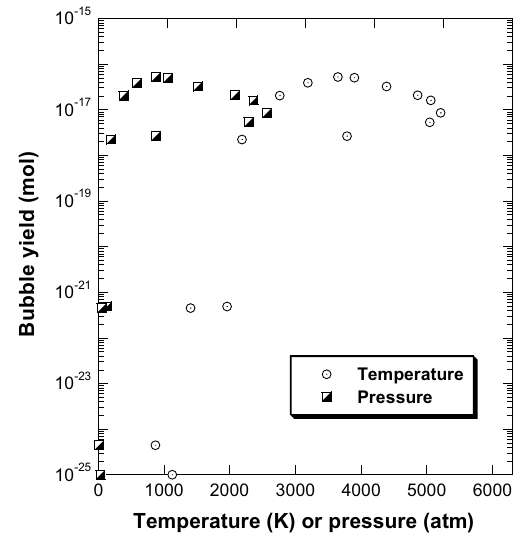
Fig. 2 Amounts of the main oxidants created inside the bubble at the end of the first bubble collapse (conditions—ambient bubble radius: 1.2 µm, liquid temperature: 25 °C, pressure: 1 atm, frequency: 1700 kHz, power: 15 W). Vertical axis is in logarithmic scale